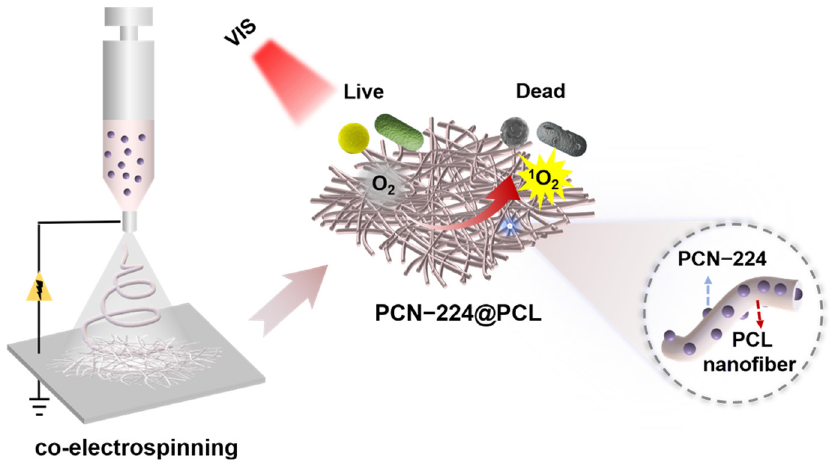
Scheme 1. Schematic diagram of the preparation of the PCL nanofibrous membranes containing PCN − 224 NPs (PM NFMs) photodynamic antibacterial